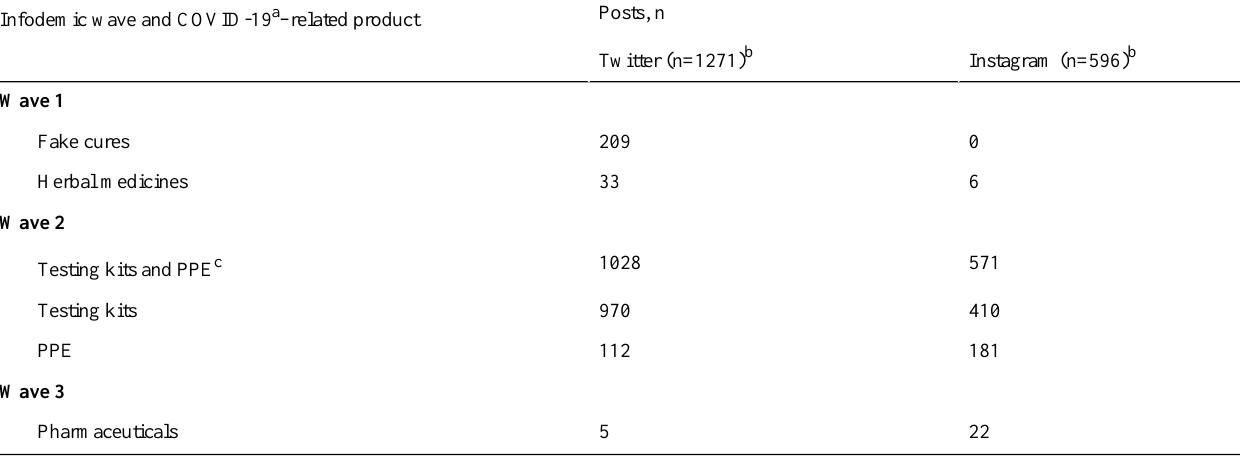
Posts, nInfodemic wave and COVID-19 a –related